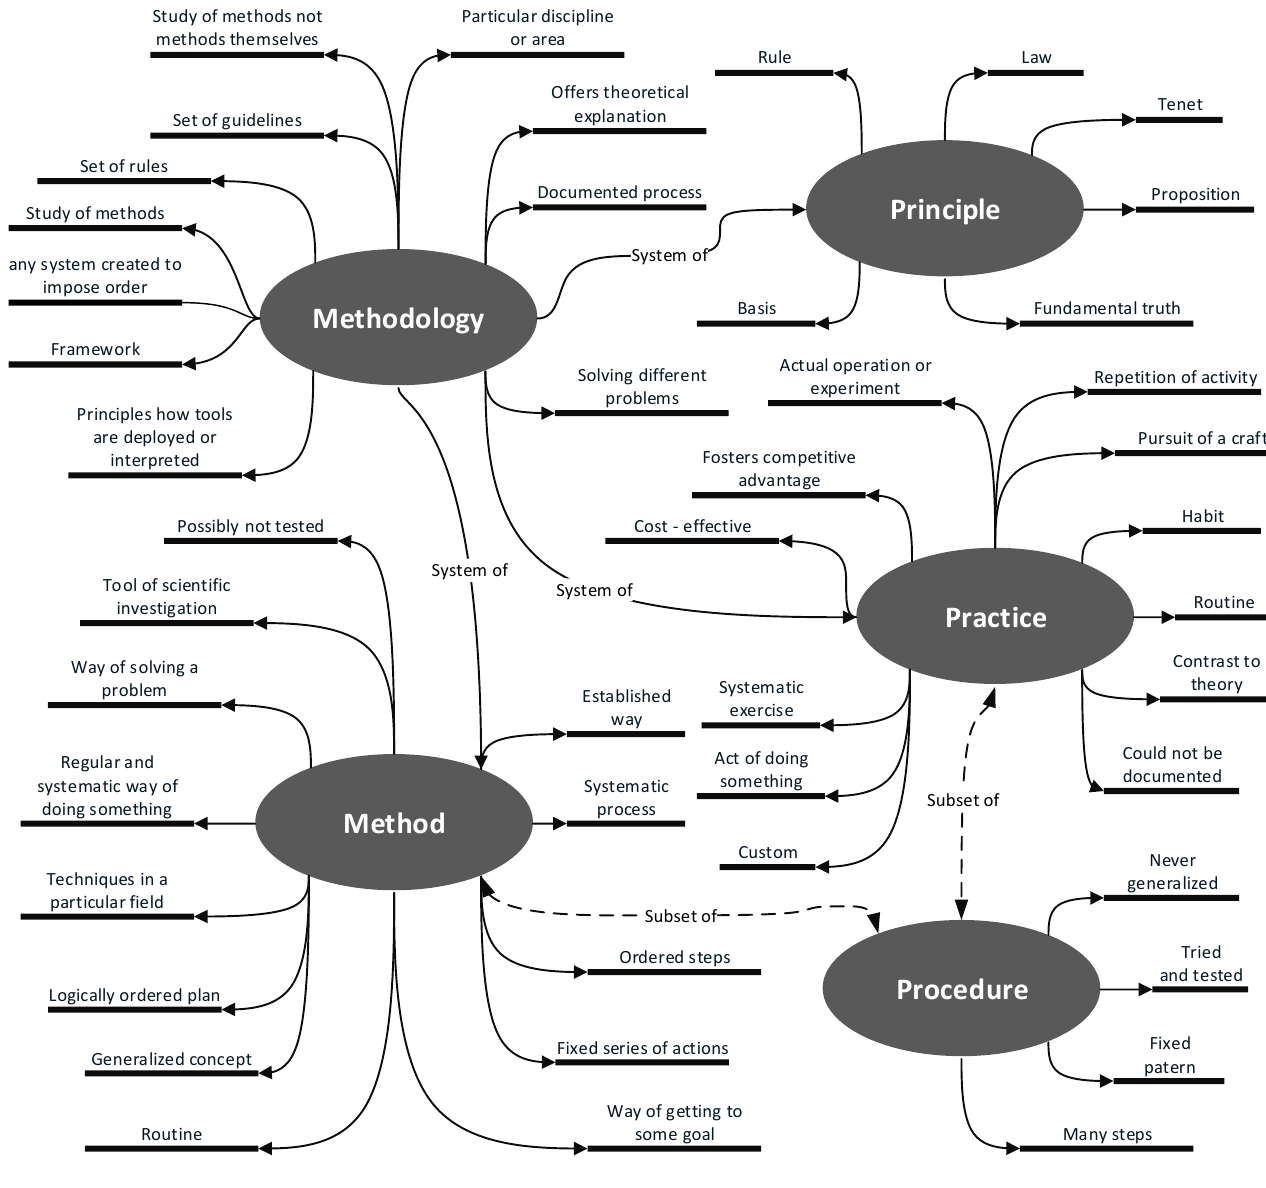
Fig. 1. Core terms and their